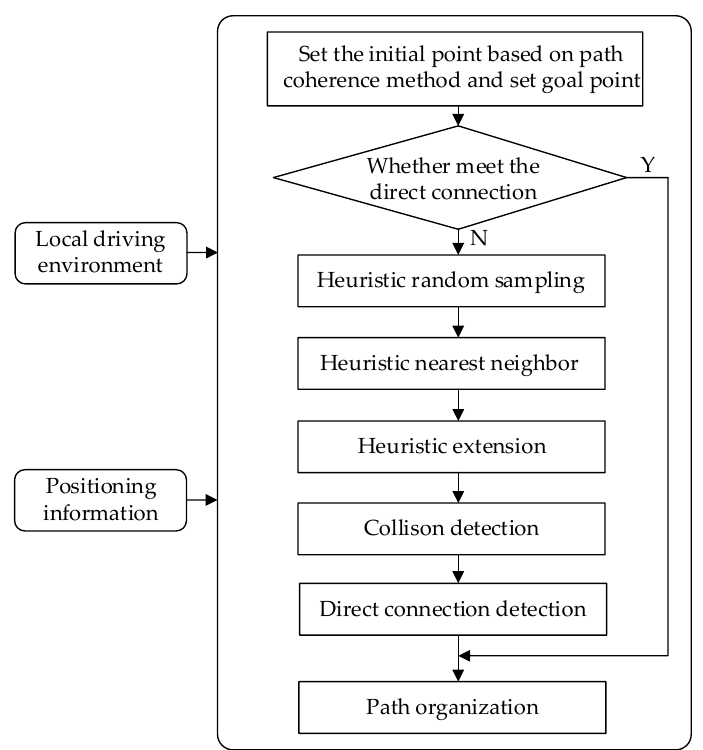
Figure 4. Model structure of the improved heuristic Bi-RRT. Algorithm 3: Build Improved Heuristic Bi-RRT ( init